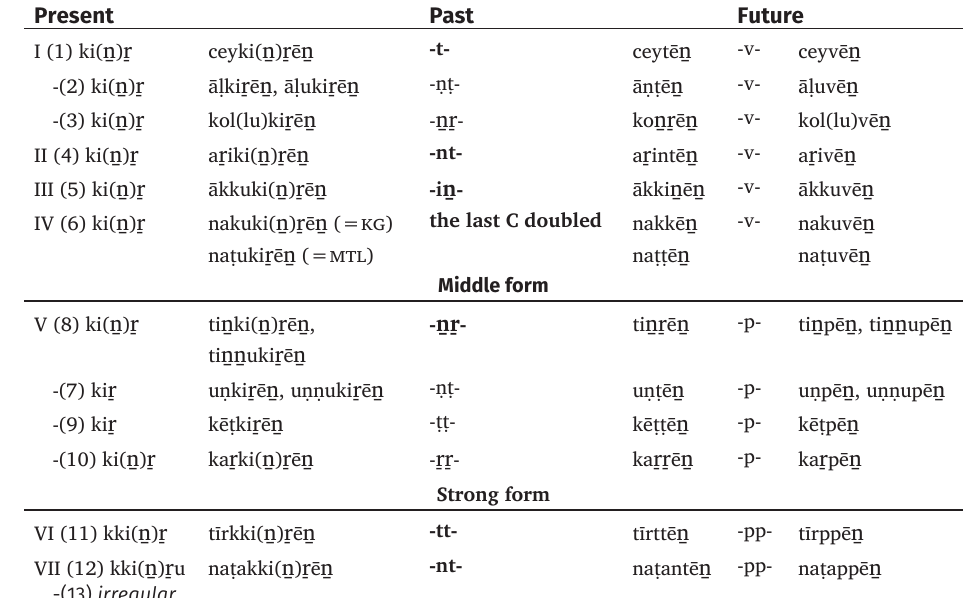
Table 2: Tamil verb